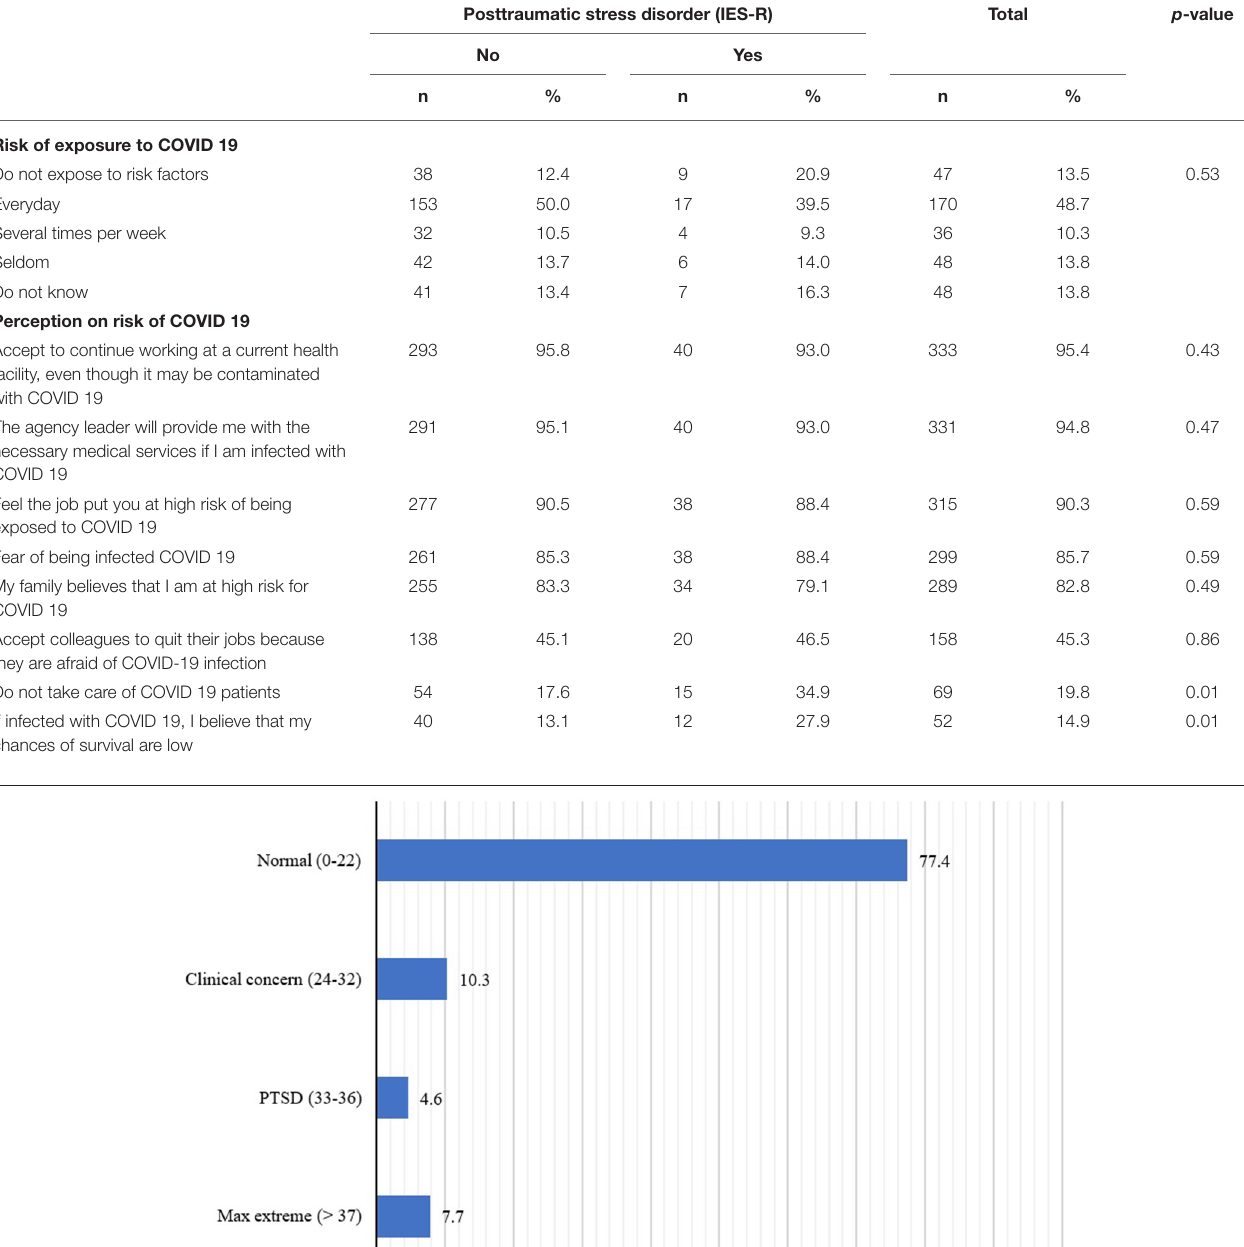
TABLE 2 | Risk of exposure to COVID-19.